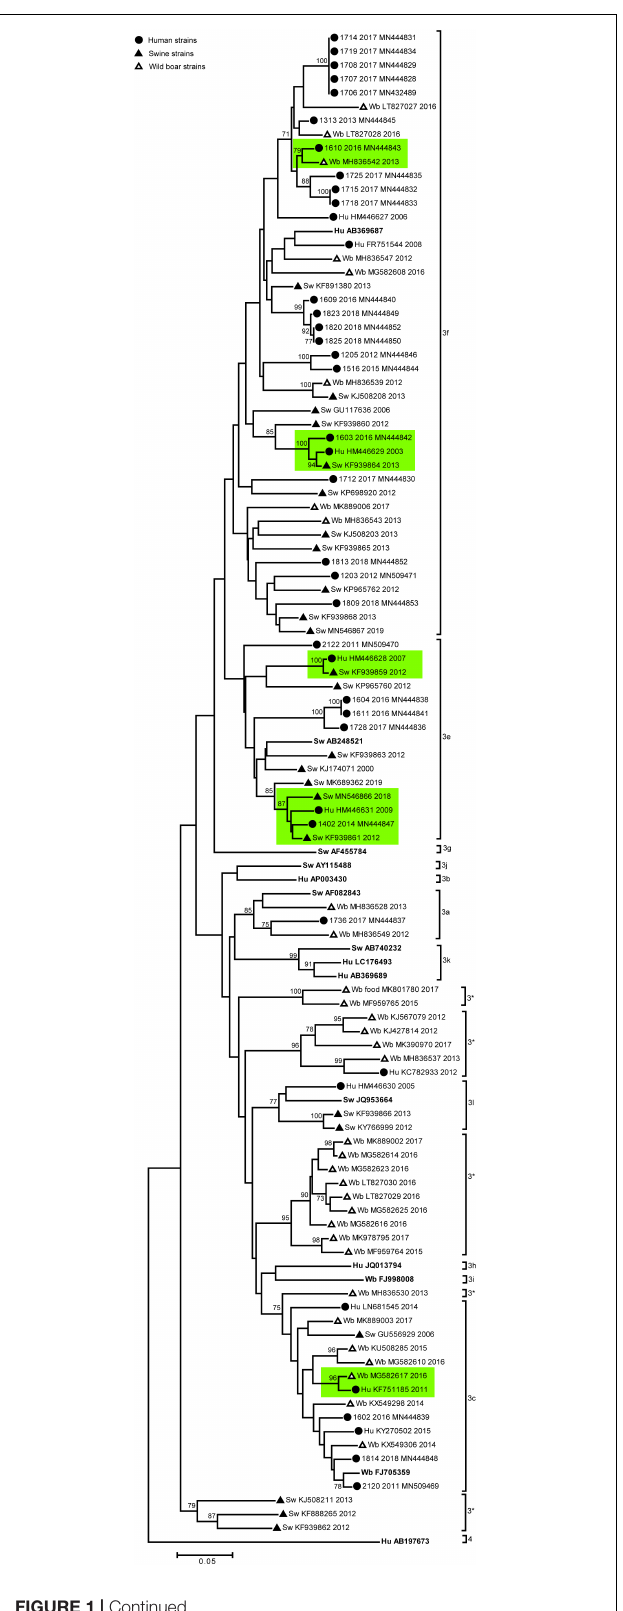
FIGURE 1 | Phylogenetic analysis based on a 300 nt fragment of the partial ORF2 region of Italian HEV strains ( n = 96) of human and animal (swine and wild boar) origin and 13 HEV subtype reference strains. The HEV-4 sequence (Hu AB197763 JP) was used as outgroup. The maximum likelihood tree was produced using the Tamura–Nei parameter model based on 1,000 bootstrap replications and bootstraps values > 70 are indicated at their respective nodes. The Italian entries downloaded from NCBI database includes host (Hu, human; Sw, swine; Wb, wild boar) accession number and year of collection. The human Italian strains from this study were reported by sequence name and accession number. The HEV reference strains are reported in bold. Human and animal sequences forming strictly related clusters are highlighted in green. Symbol disclosure is included in the